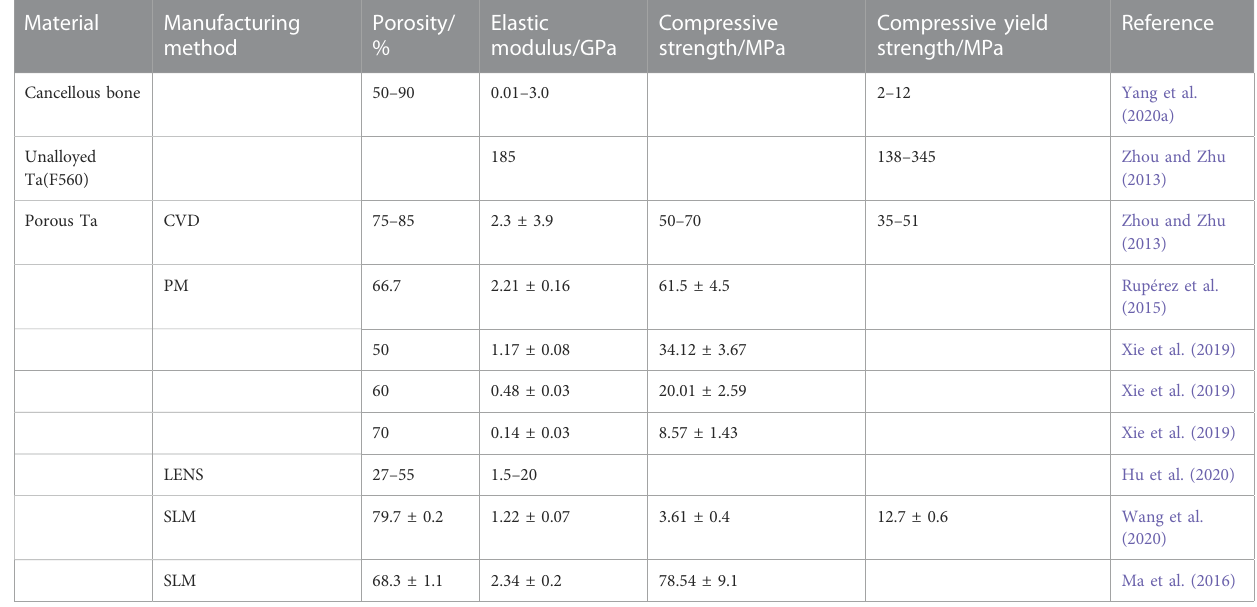
TABLE 1 Preparation technology, porosity, and mechanical properties of porous